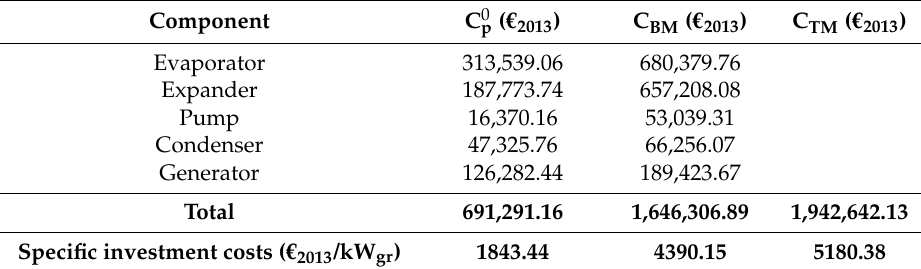
Table 5. Total investment costs estimation with the Module Costing Technique